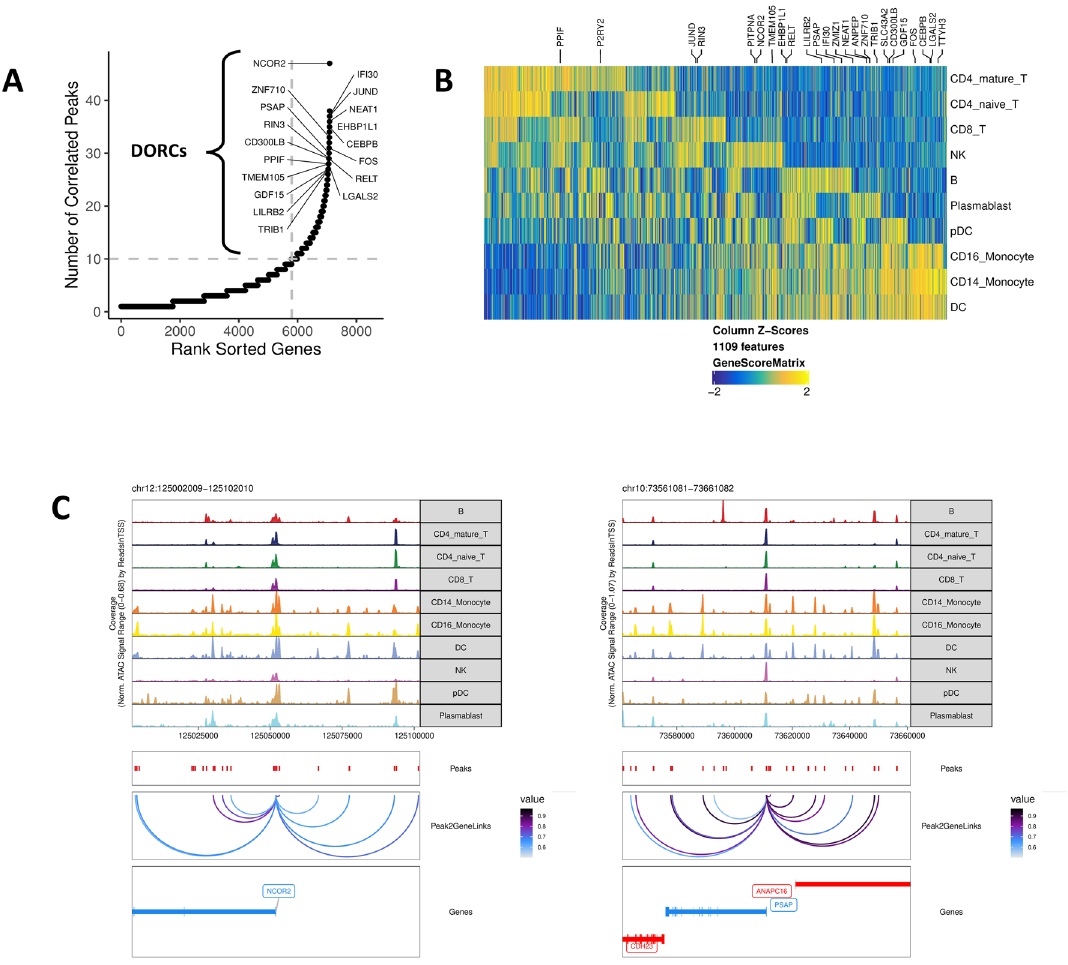
Figure 4. Domains of regulatory chromatin (DORCs) are enriched in myeloid cells, indicating epigenetic control of cell fate. ( A ) Number of peak-to-gene linkages in cells from IgG− subjects is shown by a plot of rank sorted genes as a function of number of correlated peaks. Genes with > 10 linkages are defined as DORCs. Labeled genes are known to be regulated by a super-enhancer. ( B ) DORC gene activity for 1109 loci plotted for each cell type (right). Labeled DORC genes are known to be regulated by a super-enhancer (top). ( C ) Super- enhancer regulated DORC genes for nuclear receptor corepressor 2 (NCOR2, left) and prosaposin (PSAP, right). Peak-to-gene linkages in CD14+ monocytes and other myeloid cells are plotted with a correlation cutoff of Domains of regulatory chromatin are specially enriched in myeloid cells.